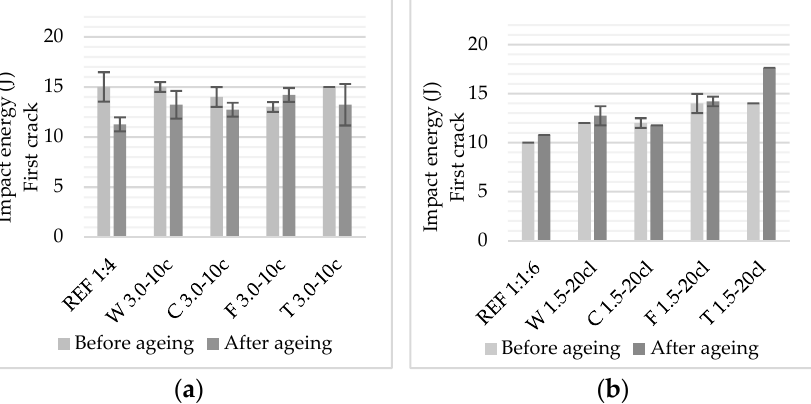
Figure 4. Impact energy before and ageing at first crack of the mortars: ( a ) cement mortars and ( b ) cement-lime mortars.